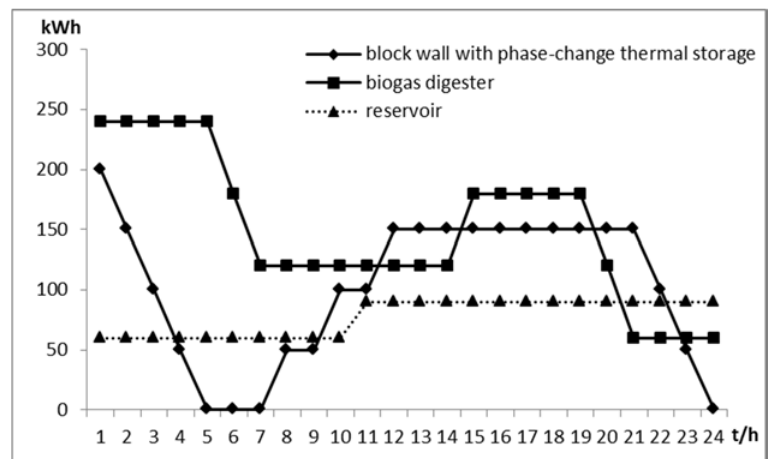
Figure 7. Comparison curve of load before and after optimization on a rainy winter day.